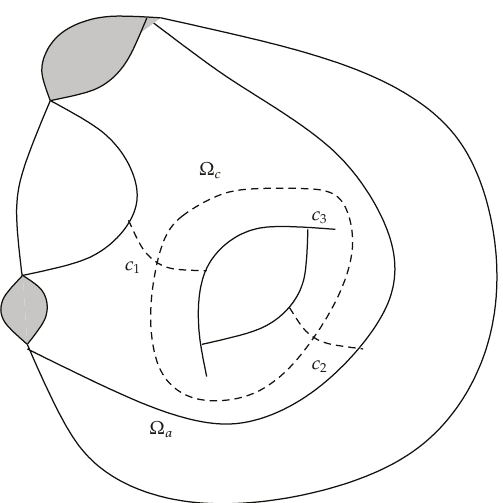
Figure 9: Multiformulational field problem. It is often economical to use di ff erent field problem formulations in the conducting domain Ω c and in the nonconducting domain Ω a . 1-chain cosets (cid:3) c 1 (cid:4) , (cid:3) c 2 (cid:4) , and (cid:3) c 3 (cid:4) generate H 1 (cid:6) ∂ Ω c ∩ ∂ Ω a (cid:7)